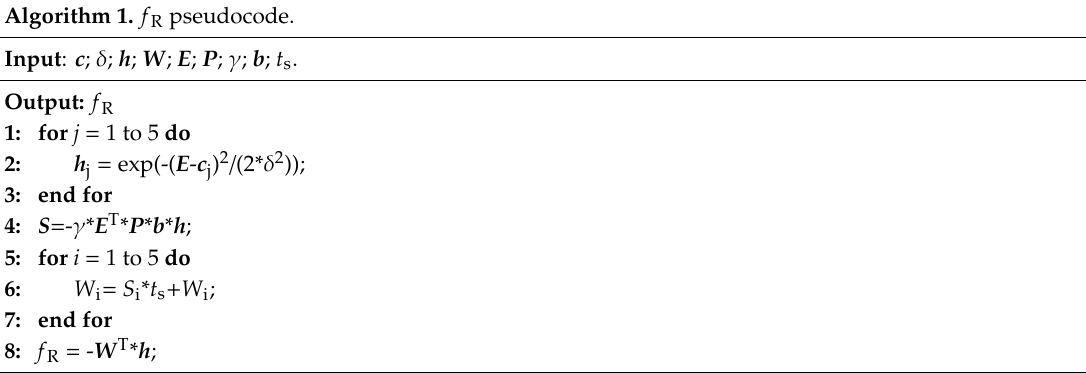
Algorithm 1. f R